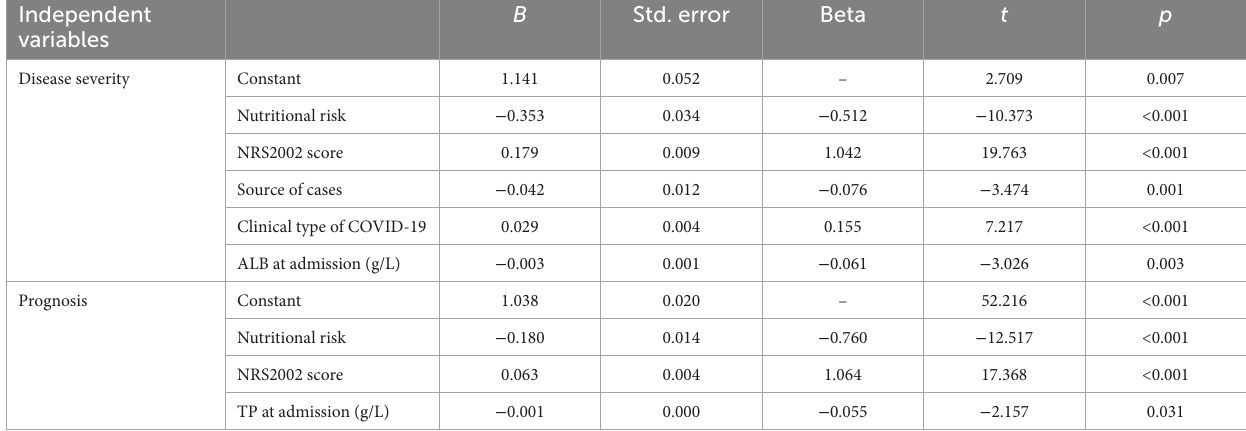
TABLE 5 Multiple stepwise regression analysis of influencing factors of the disease severity and the prognosis ( n = 1,228). Independent variables